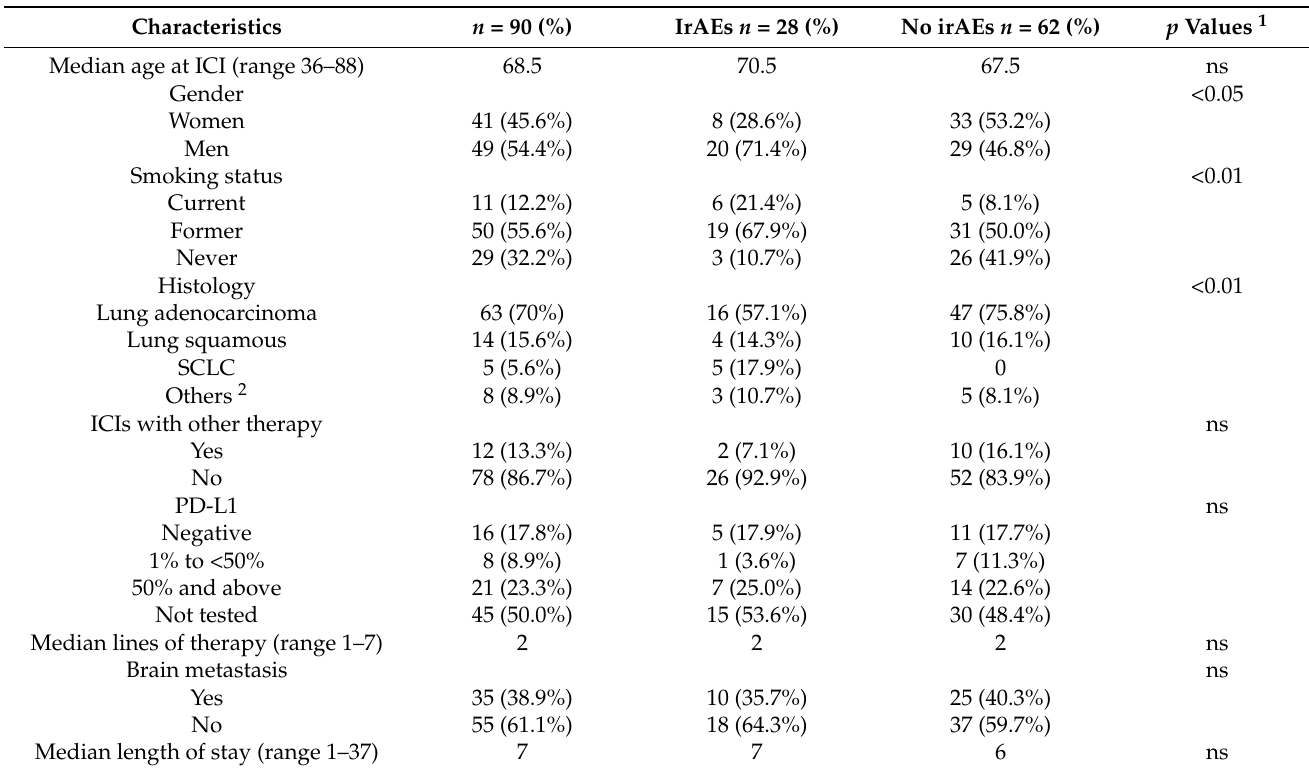
Table 2. Baseline patient